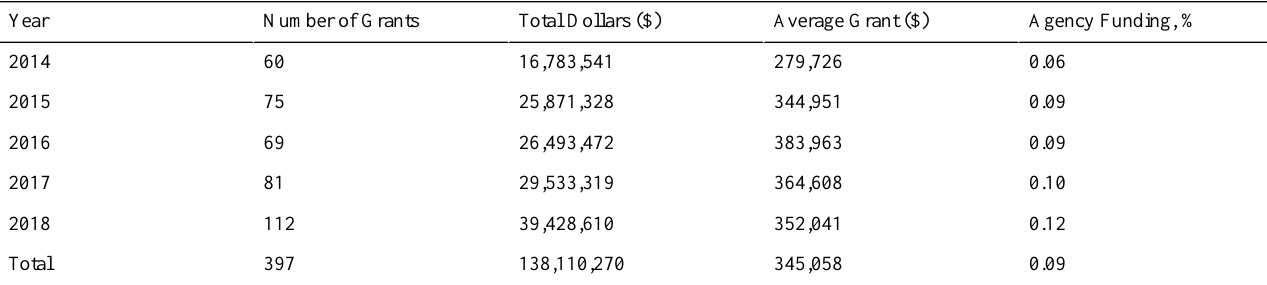
Table 1. Year of funding and one-year grant awards.